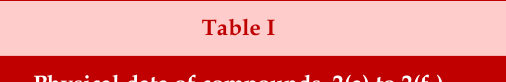
Physical data of compounds, 2(a) to 2(f 2